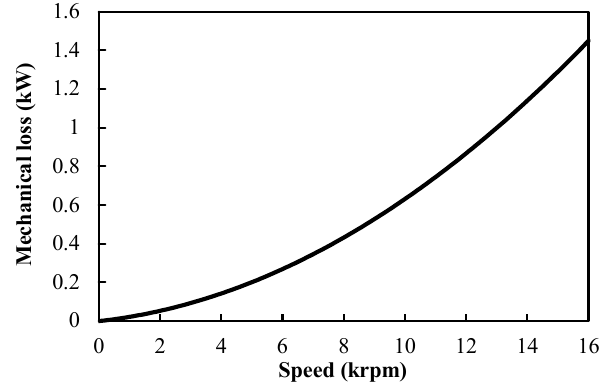
Figure 31. Variation of mechanical loss with speed [40].